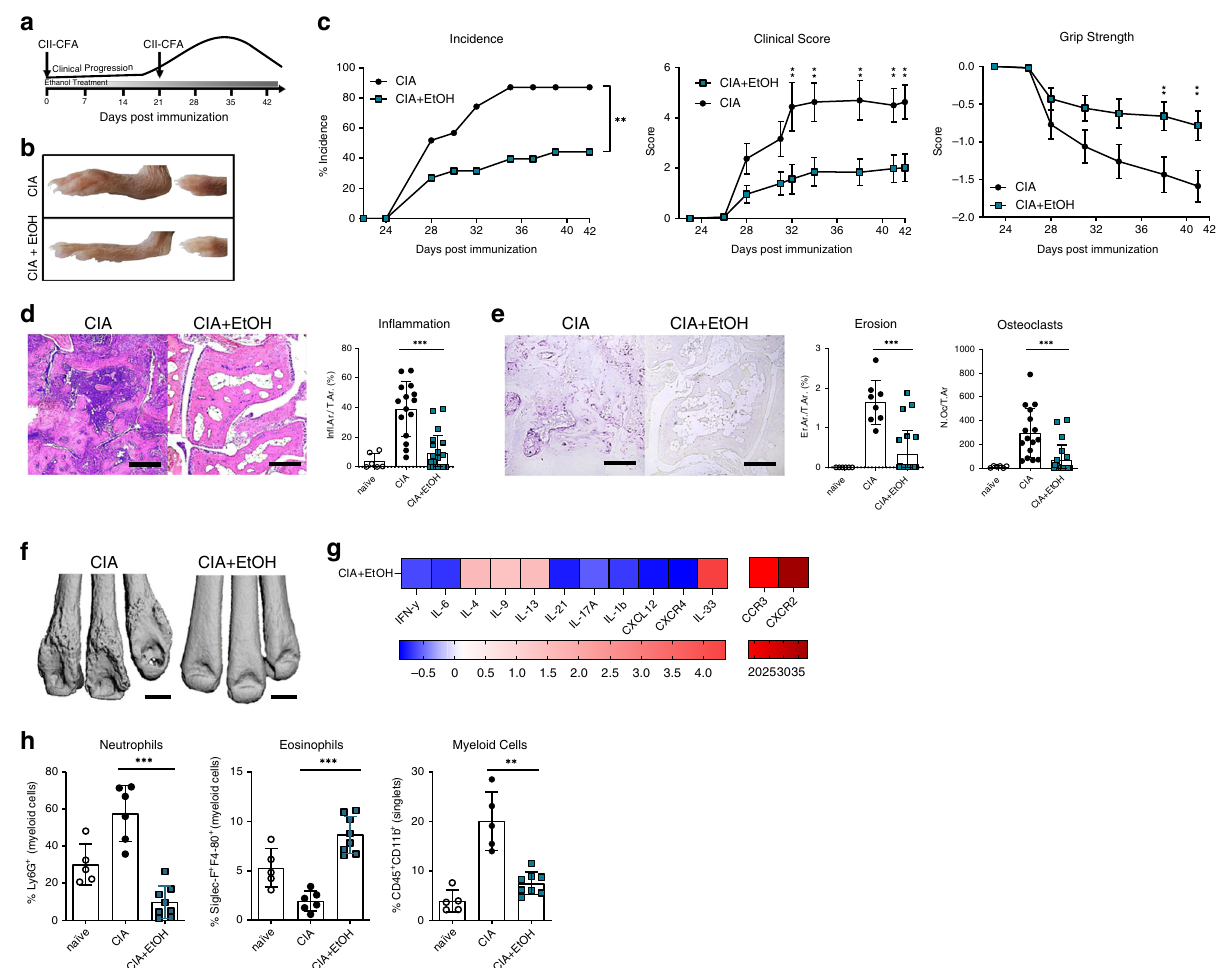
Fig. 1 Alcohol exposure inhibits arthritis. a Schematic overview of the experimental setup in DBA/1 mice induced for collagen arthritis (CIA). b Representative images of hind paws and c incidence, clinical score and grip strength of vehicle-exposed mice (CIA, n = 10 mice) or alcohol-exposed mice (CIA + EtOH, n = 10 mice). d Representative images of H&E stained paw sections and histological quanti fi cation of in fl ammation area per tissue area (In fl . Ar./T.Ar.) in the hind paws (combined three independent experiments, naive n = 6, CIA, n = 8, CIA + EtOH, n = 21 mice). Scale bar, 500 µ m. e Representative images of TRAP stained paw sections and histological quanti fi cation of eroded area per tissue area (E.Ar./T.Ar.) and osteoclast number per tissue area (N.Oc./T.Ar.) in the hind paws (combined three independent experiments, naive n = 6, CIA, n = 16, CIA + EtOH, n = 21 mice). Scale bar, 500 µ m. f Representative µ CT images of the tarsal joints of vehicle-exposed mice (CIA) or alcohol-exposed mice (CIA + EtOH). Scale bar, 200 µ m. g Heat map exhibition of Log 2 average fold change of relative mRNA expression levels of cytokine and chemokine mediators in the in fl amed paws analyzed by RT- PCR at 42 dpi. h Flow-cytometry quanti fi cations of neutrophils, eosinophils and monocytes at 42 dpi in cell suspensions from hind paws (naive n = 5, CIA, n = 6, CIA + EtOH, n = 8 mice). N number represents number of animals used per experiment. Data shown from one of three independent experiments and expressed as mean ± SD, except for d and e , which represent combined data. Statistical difference was determined by two-way ANOVA ( c ) or Students two-tailed t -test ( d , e , g , h ). * p < 0.05; ** p < 0.01; *** p <